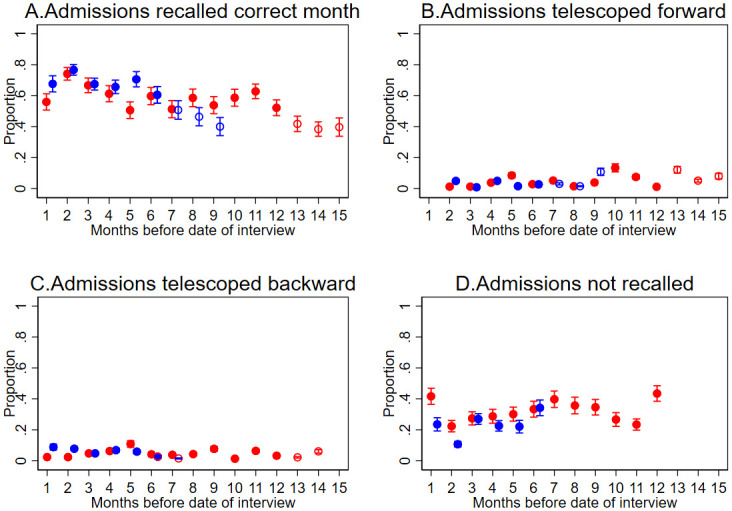
Recall errors by the time difference between the admission and the interview.Dots: proportion of admissions; Error bars: 95% confidence intervals. Red shaded dots: 12-month recall period from 1 to 12 months since transaction date. Red unshaded dot: 12-month recall period from 13 to 15 months since transaction date. Blue shaded dot: 6-month recall period from 1 to 6 months since transaction date. Blue unshaded dot: 6-month recall period from 7 to 9 months since transaction date.